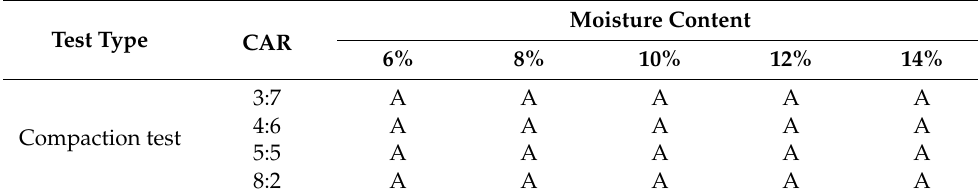
Table 3. Compaction test group design table.